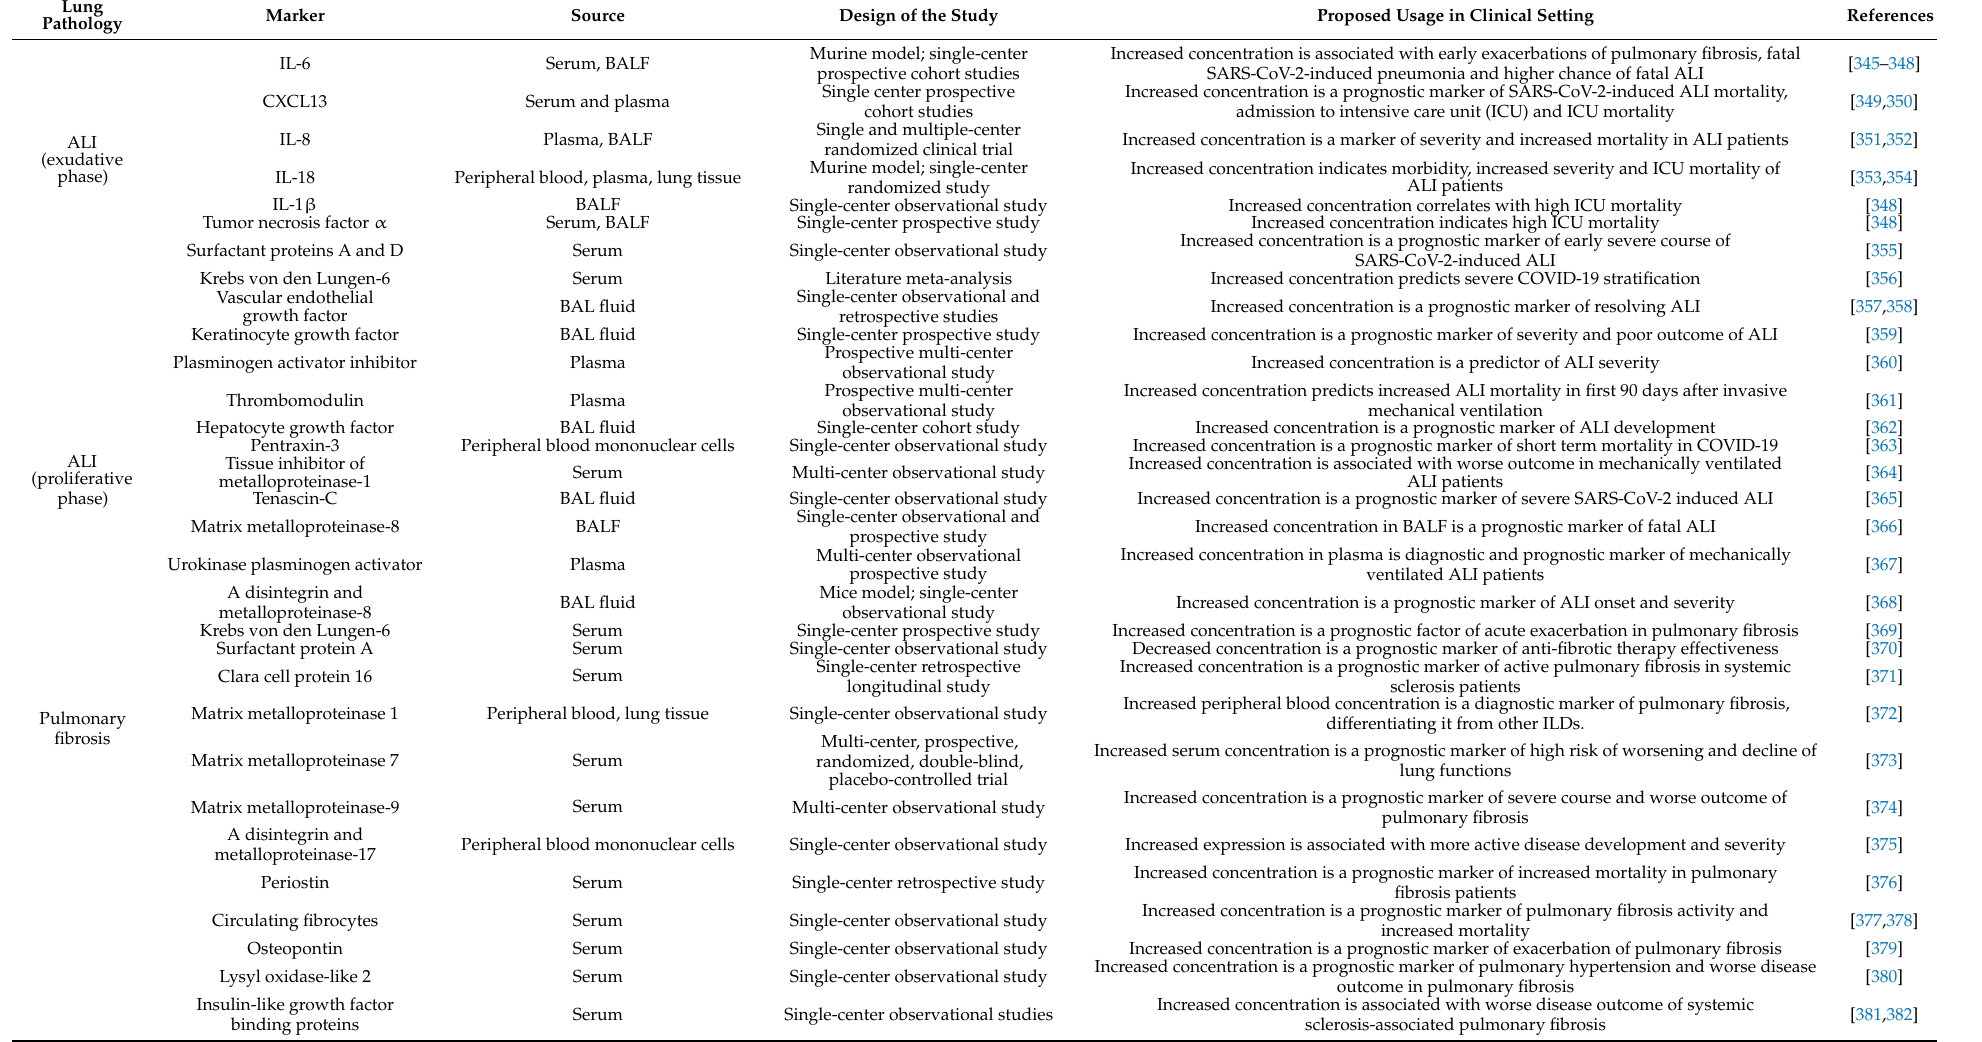
Table 3. Established and potential prognostic markers of ALI and pulmonary